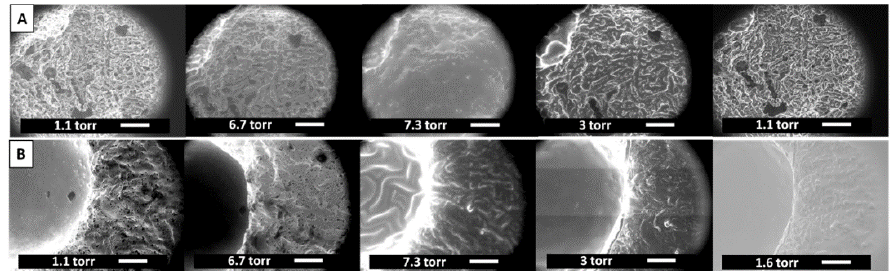
Figure 3. ESEM images in the wet mode of the biomimetic scaffold during hydration and dehydration cycles as controlled by water vapour pressure. ( A ) Selected top-view images showing the HAMA hydrogel (left size of the images) scale bars = 200 µm, and ( B ) Bottom-view images of the porous support. Scale bars = 100 µm.